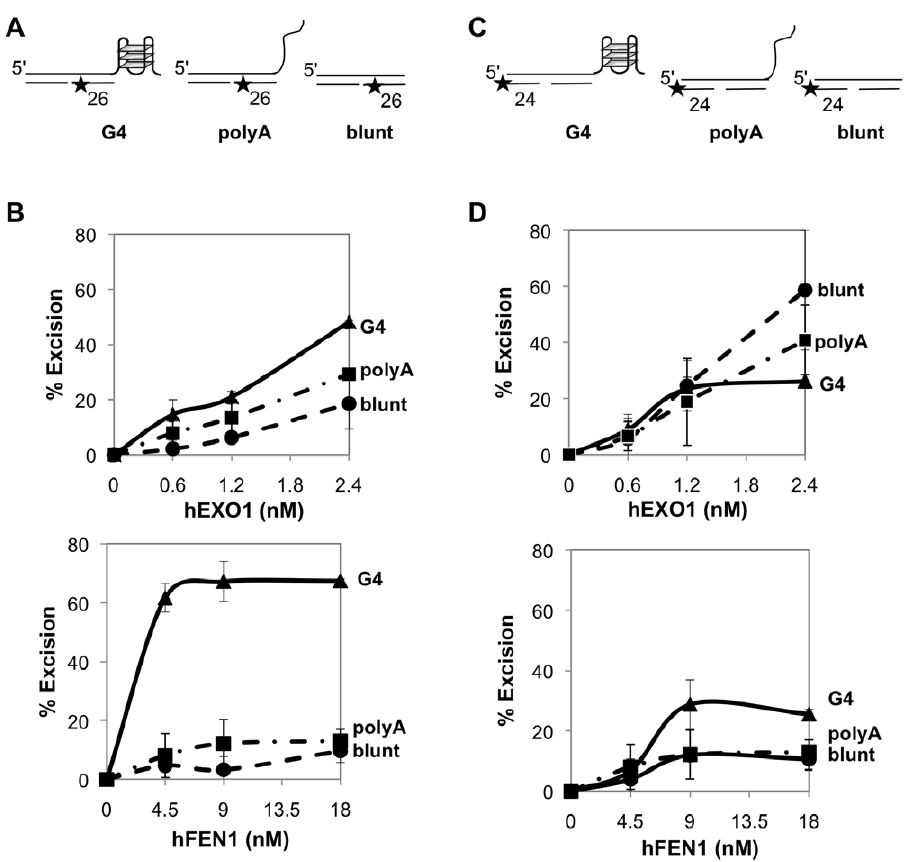
Figure 5. A telomeric tail stimulates hEXO1 and hFEN1 excision on the opposite strand. (A) Diagram of duplex substrates for assay of excision opposite a G4 DNA (TTAGGG) 4 tail, a polyA 24 tail, or a blunt end. Sizes of 3 9 -labeled oligonucleotides are indicated; asterisks, end-label. (B) Quantitation of hEXO1 (0, 0.6, 1.2 and 2.4 nM, above) or hFEN1 (0, 4.5, 9.0 and 18 nM, below) excision of substrates diagrammed in panel A. G4 DNA tails, triangles; 3 9 poly(A) 24 tails, squares and blunt ends, circles. (C) Diagram of duplex substrates for assay of excision at a nick on the strand opposite a G4 DNA (TTAGGG) 4 tail, a 3 9 -poly(A) 24 tail, or a blunt end, and 3 9 end-labeled on the nicked strand distal to the tail. Sizes of 3 9 -labeled oligonucleotides are indicated; asterisks, end-label. (D) Quantitation of hEXO1 (0, 0.6, 1.2 and 2.4 nM, above) or hFEN1 (0, 4.5, 9.0 and 18 nM, below) excision of substrates diagrammed in panel C. Notations as in panel B.